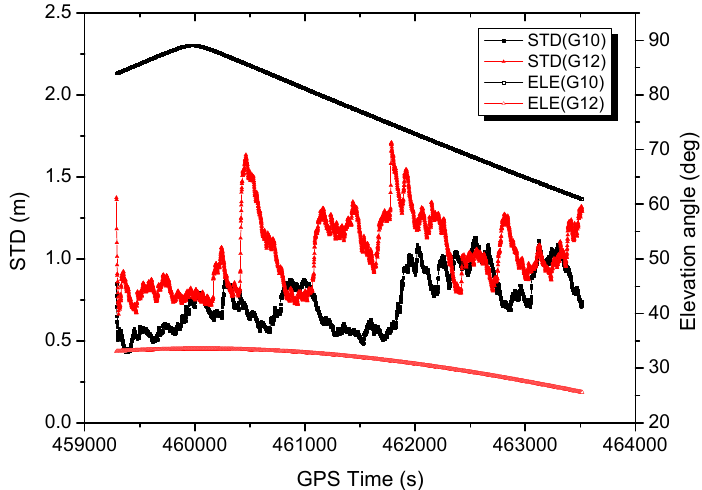
Figure 11. Estimated IF code standard deviation using adaptive strategy.